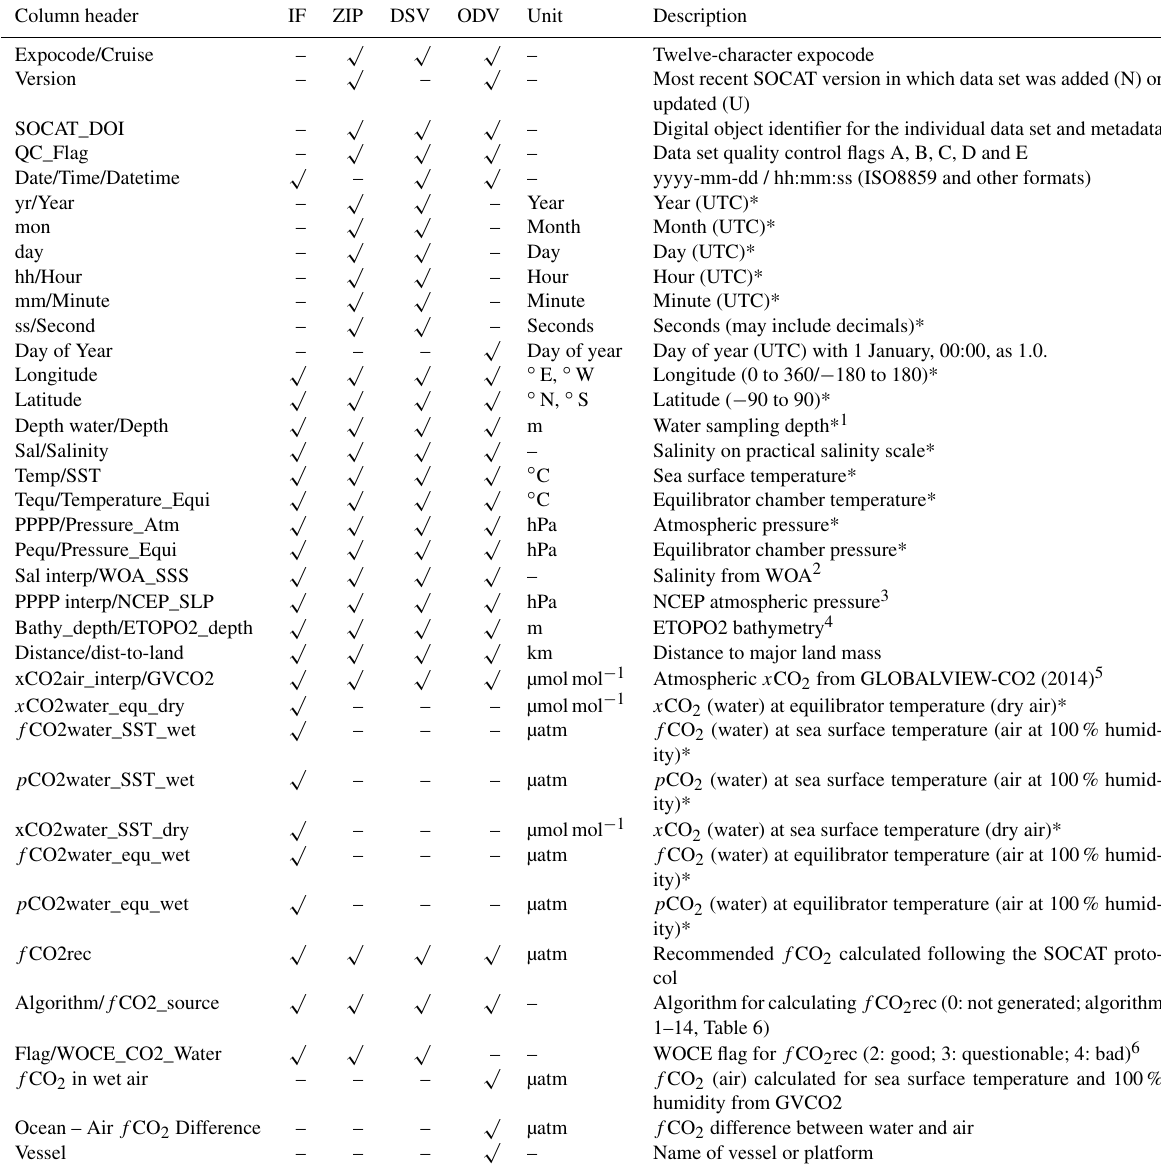
Table 9. Content of the individual data set files (IF) and the synthesis files in SOCAT version 3 (after Bakker et al., 2014). The global synthesis product is available as zip text files (ZIP) at CDIAC and in Ocean Data View (ODV) format (Table 8). Subsets of the global synthesis data set can be created via the Data Set Viewer (DSV), both in the main menu and via the Table of Datasets. The first column lists column headers for the parameters in the files.